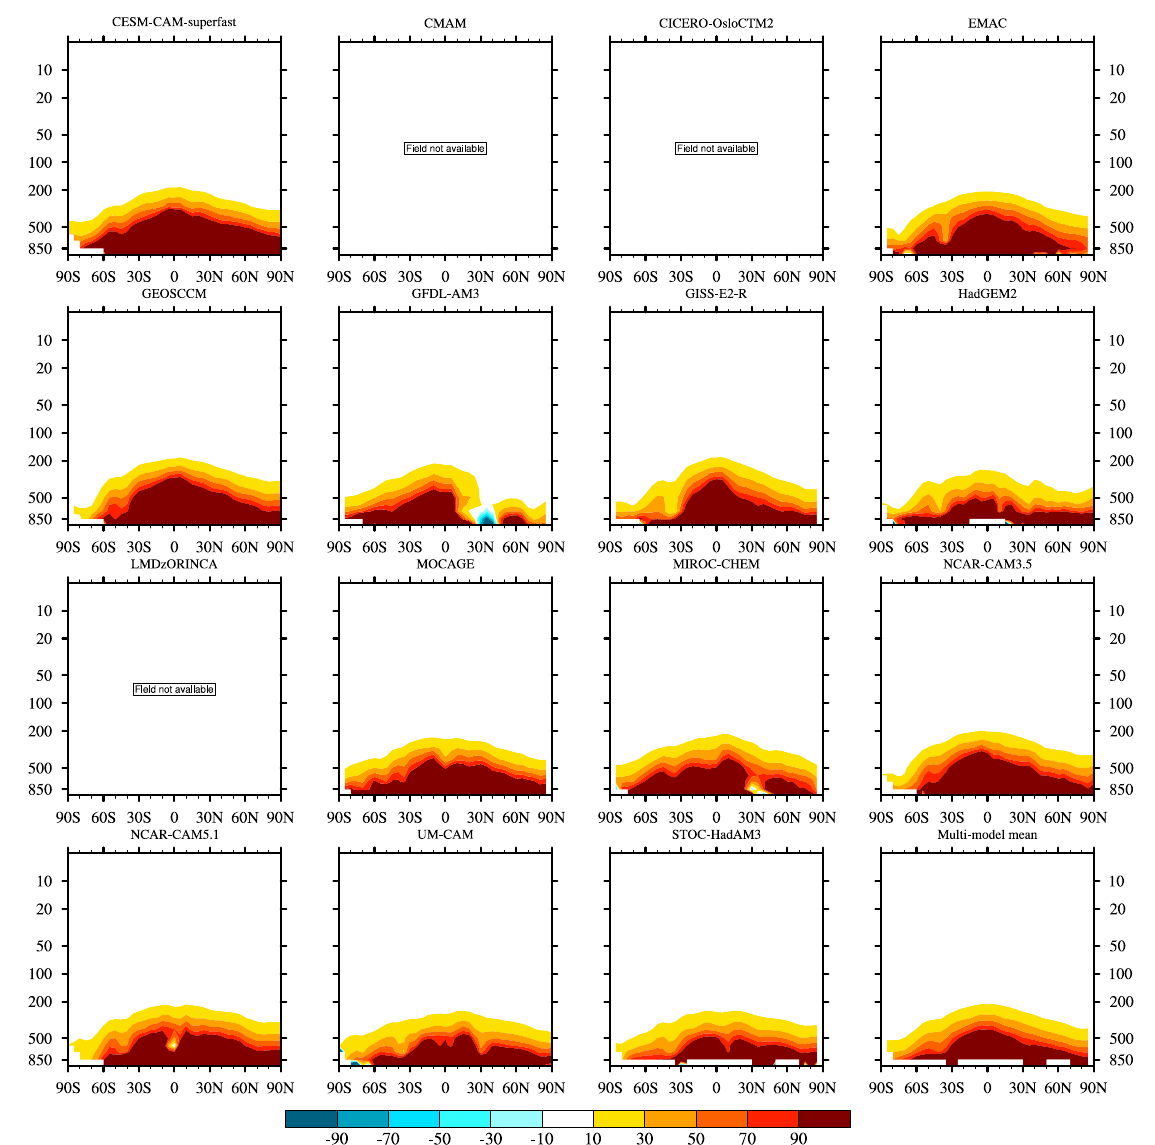
Fig. 10a. Difference 2000–1850 in annual and zonal mean specific humidity (10 − 6 kgkg − 1 ). a slight positive bias (1–2 K) in the tropical regions (Fig.